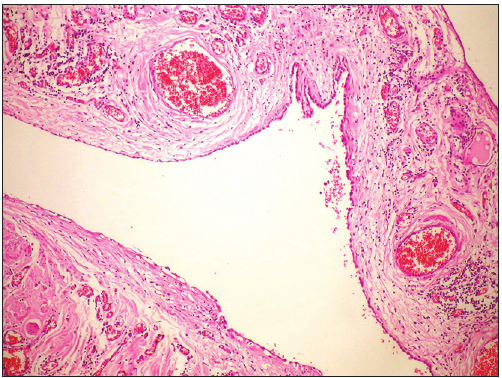
FIGURE 2. Cyctic lesion lined with single layer